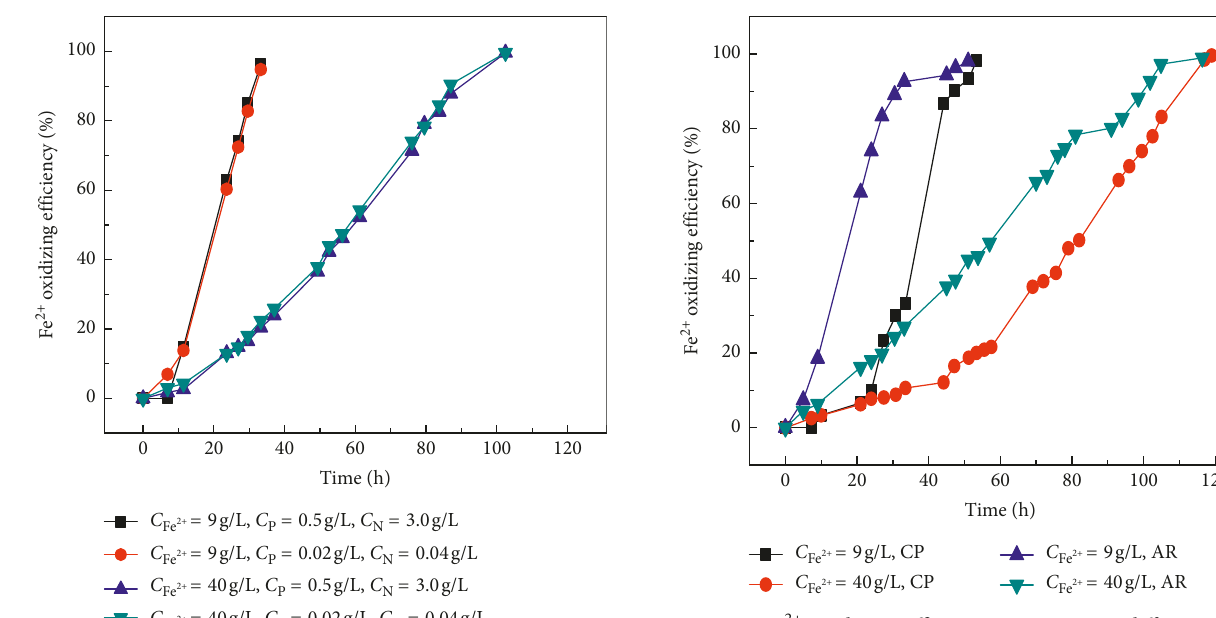
Figure 5: Fe 2+ oxidizing efficiency vs. time at a different grade ferrous sulfate.